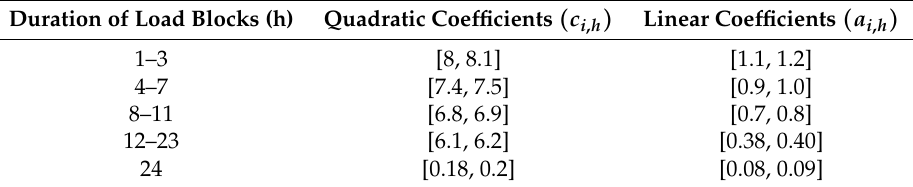
Table 1. Ranges of coefficients in firms’ cost